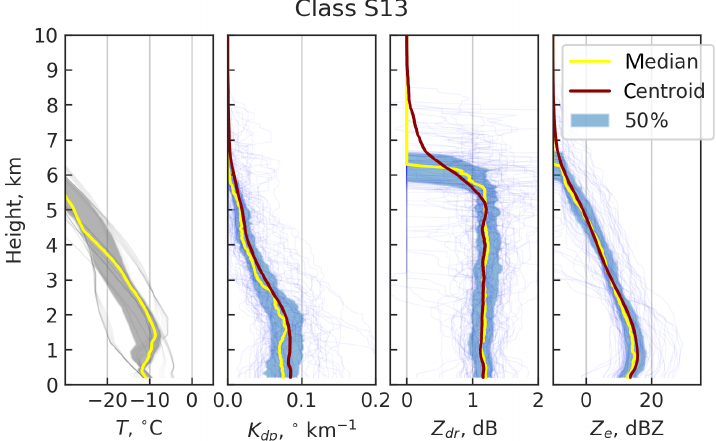
Figure 5. The class S13 centroid is visualized in the three rightmost panes. Individual class member profiles are marked with thin lines. The pane on the left shows corresponding NCEP GDAS temperature profiles. The areas between the first and the third quantiles are shaded, radar data is in blue and GDAS is in